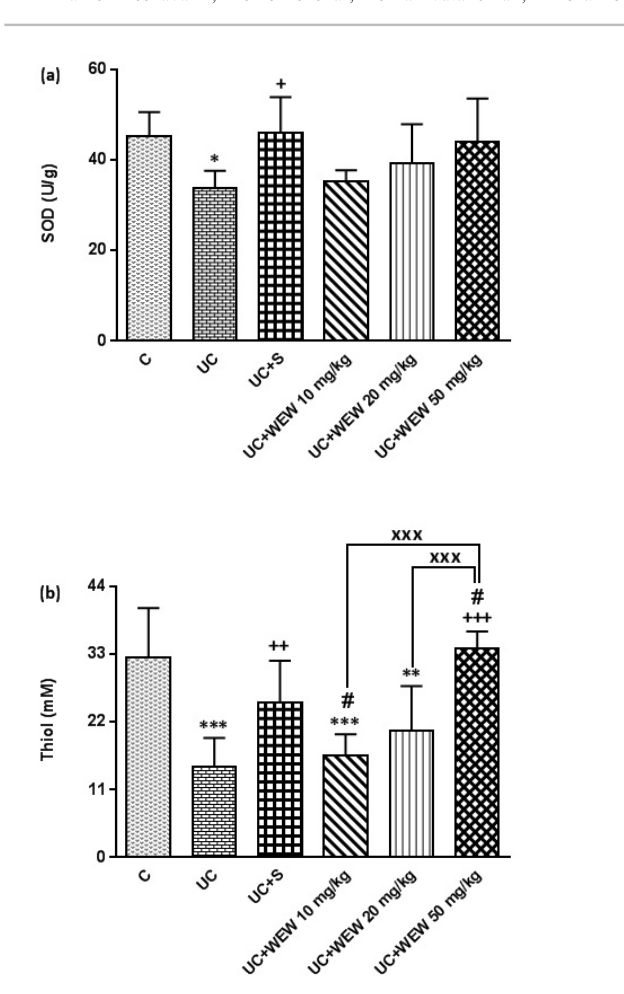
FIGURE 2 - SOD (a) and Thiol (b) levels in the colon tissue of control (C), ulcerative colitis group (UC), ulcerative colitis rats treated with sulfasalazine (UC+S) and woody endocarpium of wulnut extract (UC+WEW), (n=7 in each group). Data are presented as mean ± SEM values. * p<0.05, ** p<0.01 and *** p<0.001 shows significant differences compared to group C. + p<0.05, ++ p<0.01 and +++ p<0.001 show significant differences compared to group UC. # p<0.05 shows significant differences compared to group UC+S. xxx p<0.001 show significant differences between the three concentrations WEW. Statistical analyses were performed using ANOVA with Tukey-Kramer’s post-test.